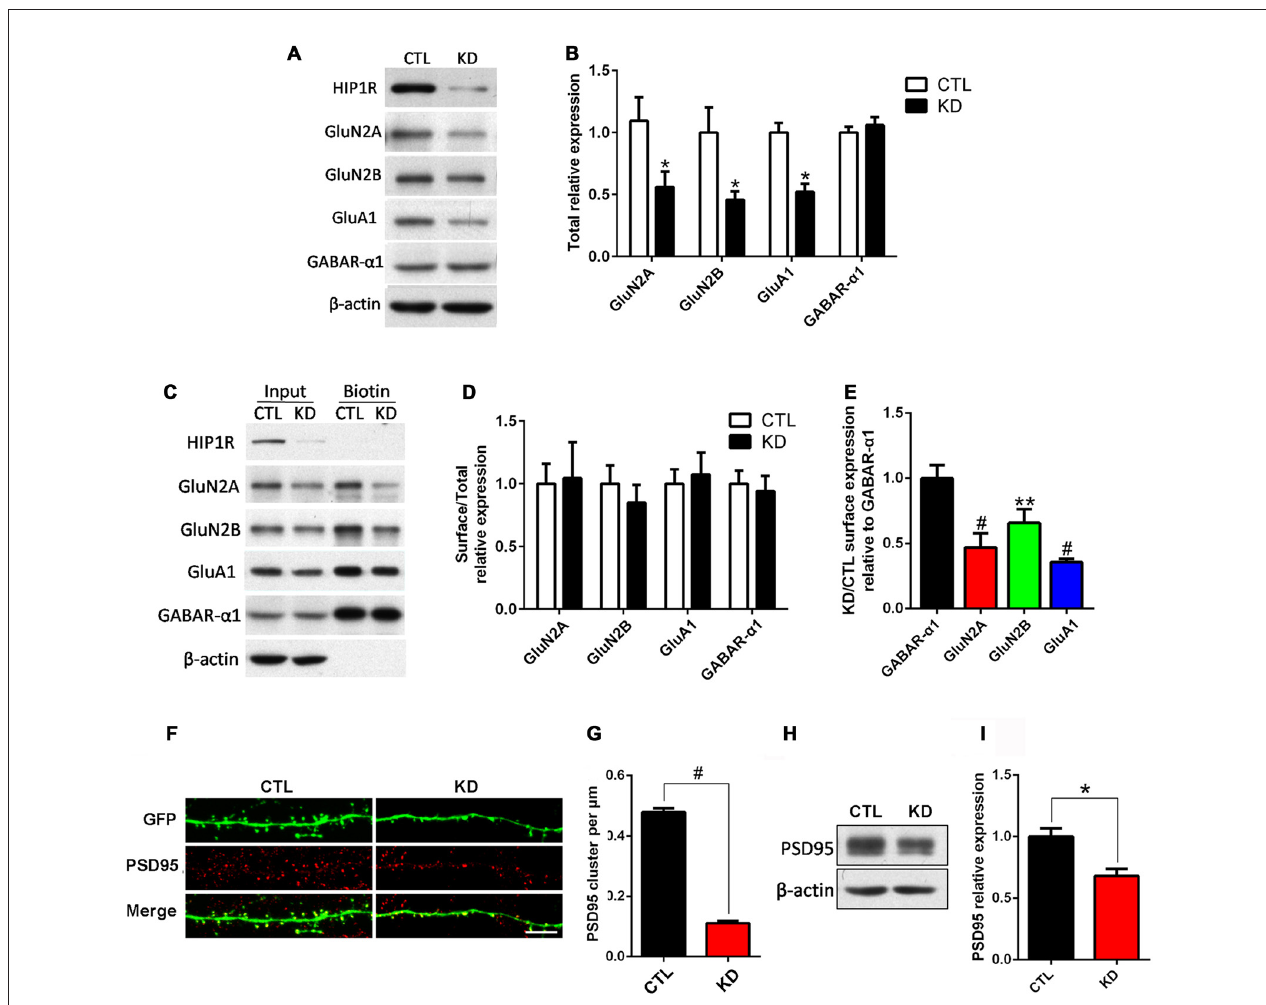
FIGURE 5 | HIP1R knockdown reduces expression of NMDARs, AMPARs and PSD95, but not GABA A . Cultured hippocampal neurons were infected with HIP1R-shRNA or Scrambled lentivirus at DIV6 and analyzed by western blotting at DIV13. (A) A representative western blot for total GluN2A, GluN2B, GluA1 and GABA A - α 1 expression. (B) Quantification of blots from repeated independent experiments showed that the total expression levels of GluN2A, GluN2B and GluA1 were significantly reduced in the HIP1R-KD group compared to the control with 0.52 ± 0.11, n = 7 vs. 1.02 ± 0.18, n = 7 for GluN2A; 0.46 ± 0.07, n = 6 vs. CTL, 1.00 ± 0.20, n = 6 for GluN2B; and 0.52 ± 0.06, n = 6 vs. 1.00 ± 0.08, n = 6 for GluA1, respectively. (C) A representative western blot for surface GluN2A, GluN2B, GluA1 and GABA A - α 1 expression. (D) The ratio of surface to total expression levels of GluN2A, GluN2B, GluA1 and GABA A - α 1 did not differ between the HIP1R-KD group and the control. (E) Surface expression levels of GluN2A, GluN2B and GluA1 were significantly reduced in the HIP1R-KD group compared to the control, when normalized for GABA A - α 1. There was no significant change in the total and surface expression levels of GABA A - α 1 in the HIP1R-KD group. The ratio of HIP1R-KD vs. the control: 0.47 ± 0.05, n = 4 for GluN2A, 0.66 ± 0.06, n = 3 for GluN2B; 0.36 ± 0.01, n = 5 for GluA1 vs. 1.00 ± 0.05, n = 5 for GABA A - α 1, respectively. (F) Representative images of dendrites immunostained using anti-PSD95 antibody at DIV16 in cultured hippocampal neurons transfected at DIV6 with HIP1R-shRNA and Scrambled vectors, respectively. (G) Quantification showed a significant decrease in the cluster density of PSD95 in the HIP1R-KD group compared to the control with 0.12 ± 0.01, n = 55 vs. 0.48 ± 0.02, n = 55, respectively. (H) Representative western blots for PSD95 of lysates from cultured hippocampal neurons at DIV13 6 days after infection with HIP1R-shRNA or Scrambled lentivirus. (I) Quantification of western blots from three independent experiments showed decreased expression of PSD95 in the HIP1R-KD group compared to the control with 0.68 ± 0.06, n = 3 vs. 1.00 ± 0.07, n = 3, respectively. All data are presented as mean ± SEM. ∗ P < 0.05, ∗∗ P < 0.01, # P < 0.0001. Uncropped images of blots are shown in Supplementary Figure S1.5A,C,H .